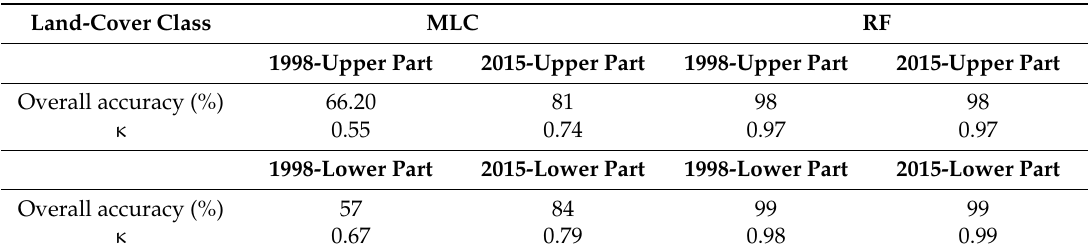
Table 4. Comparison between the accuracies of the two classification algorithms assessed by independent validation data in the upper and lower parts for 1998 and 2015 in HSCZ. Land-Cover Class MLC